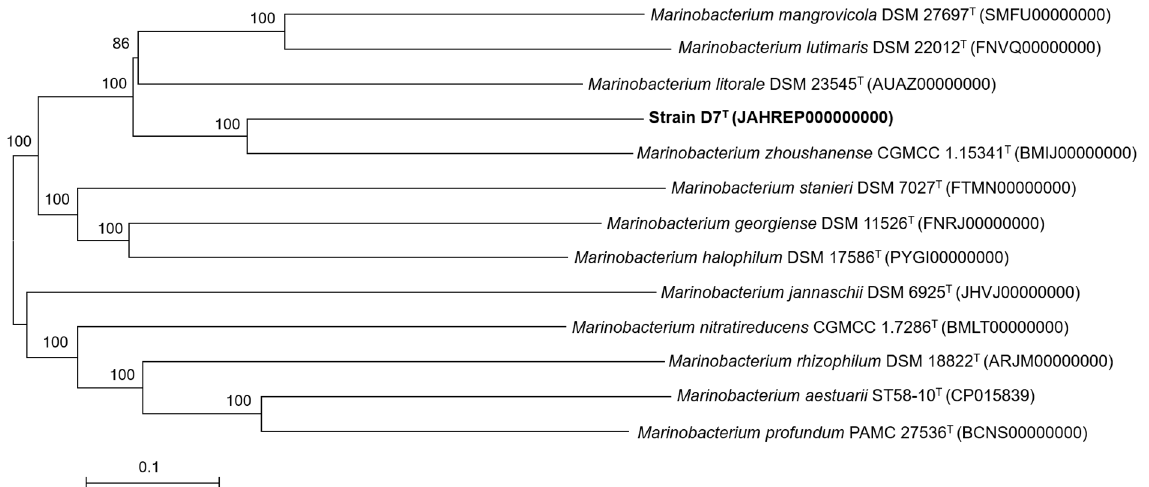
Figure 2. Venn diagram showing the number of genes shared between the genome of strain D7 T , Marinobacterium zhoushanense CGMCC 1.15341 T and Marinobacterium lutimaris DSM 22012 T .